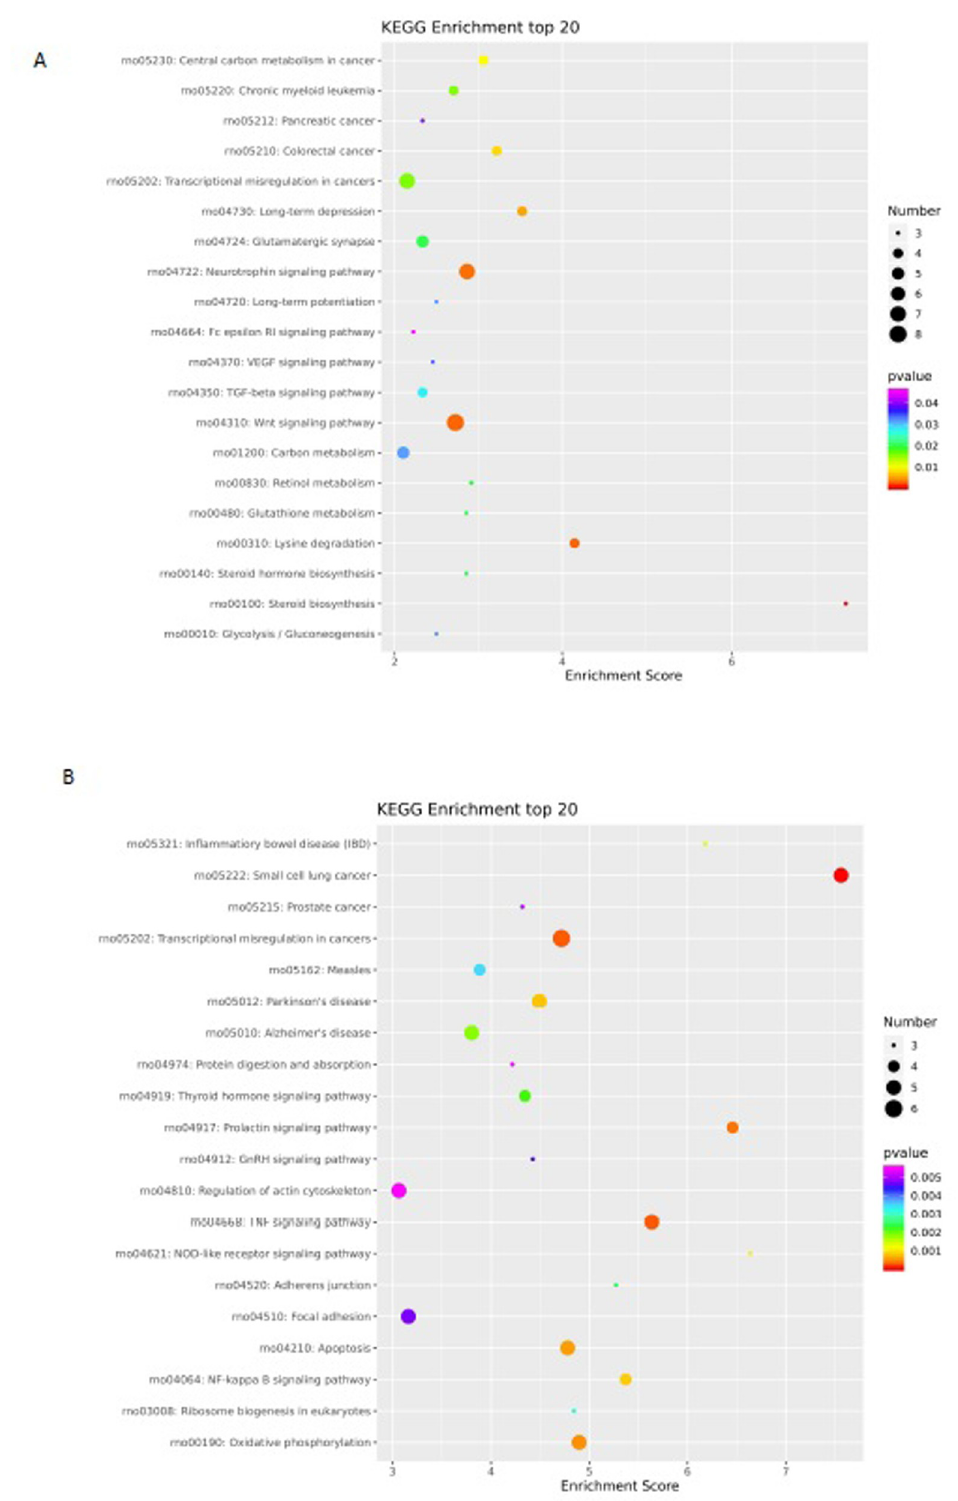
Fig 7. KEGG pathway classification of differentially methylated genes in the upstream region. KEGG pathway analysis showed that the differentially methylated genes were involved in different signaling pathways. (A) CCGG KEGG enrichment analysis; (B) CCNGG KEGG enrichment